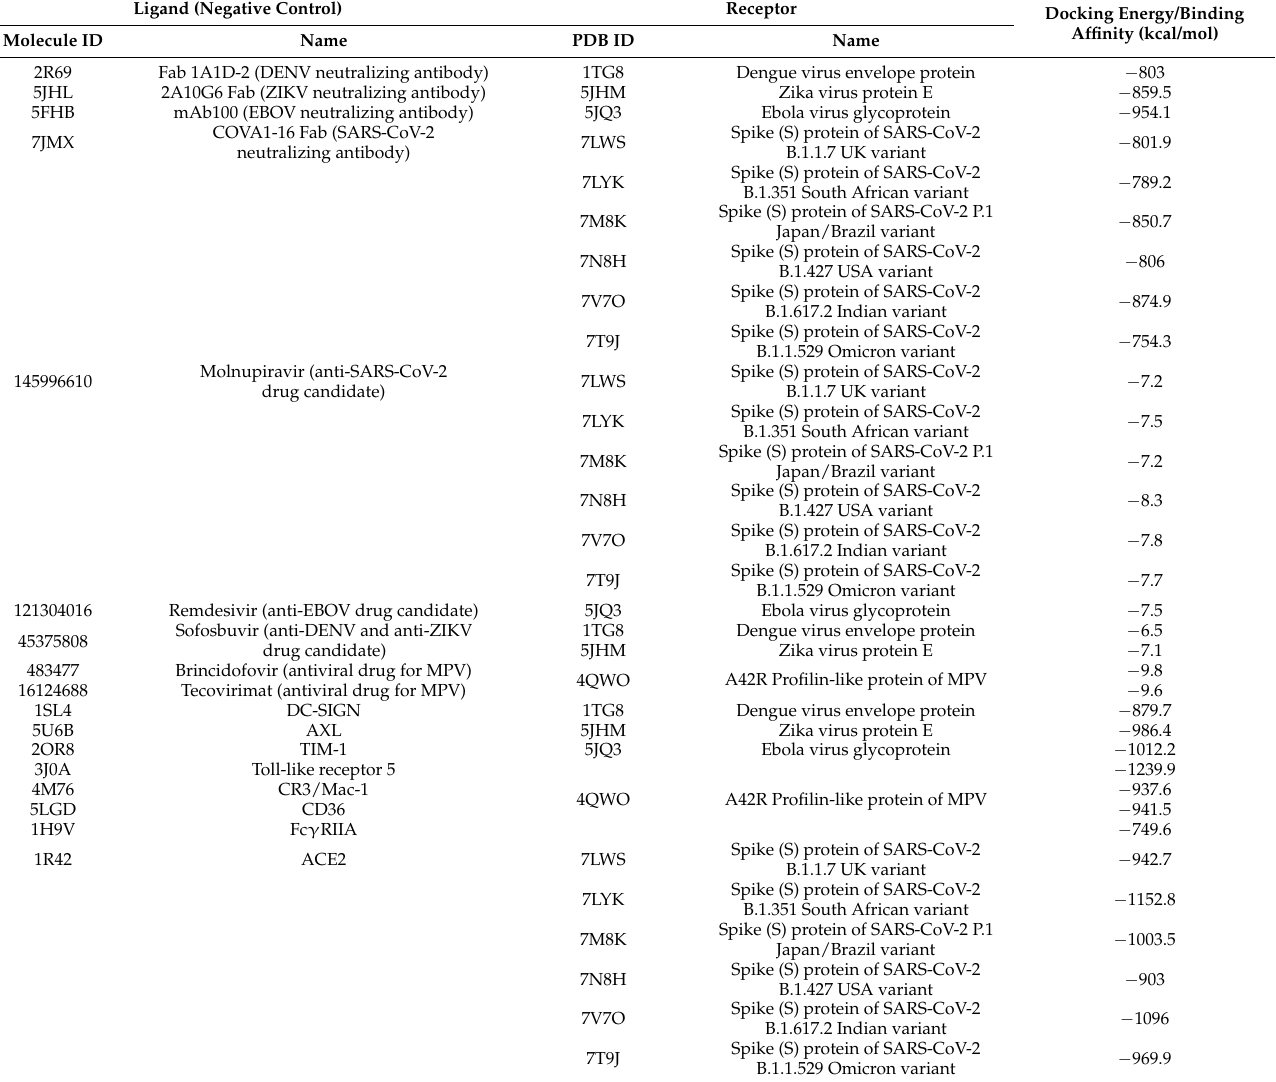
Table 1. Molecular docking data of reference materials with selected viral